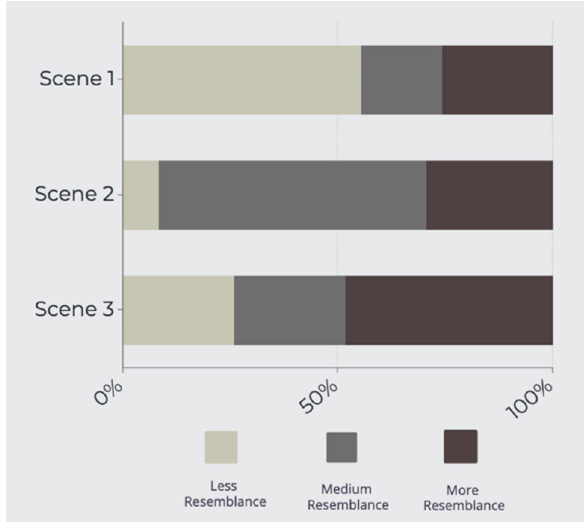
Figure 7. Resemblance of each scene with the alcohol exposure that can be found in Lavapiés Square in real-life conditions (Scene 1: null alcohol exposure; Scene 2: medium alcohol exposure; Scene 3: high alcohol exposure).